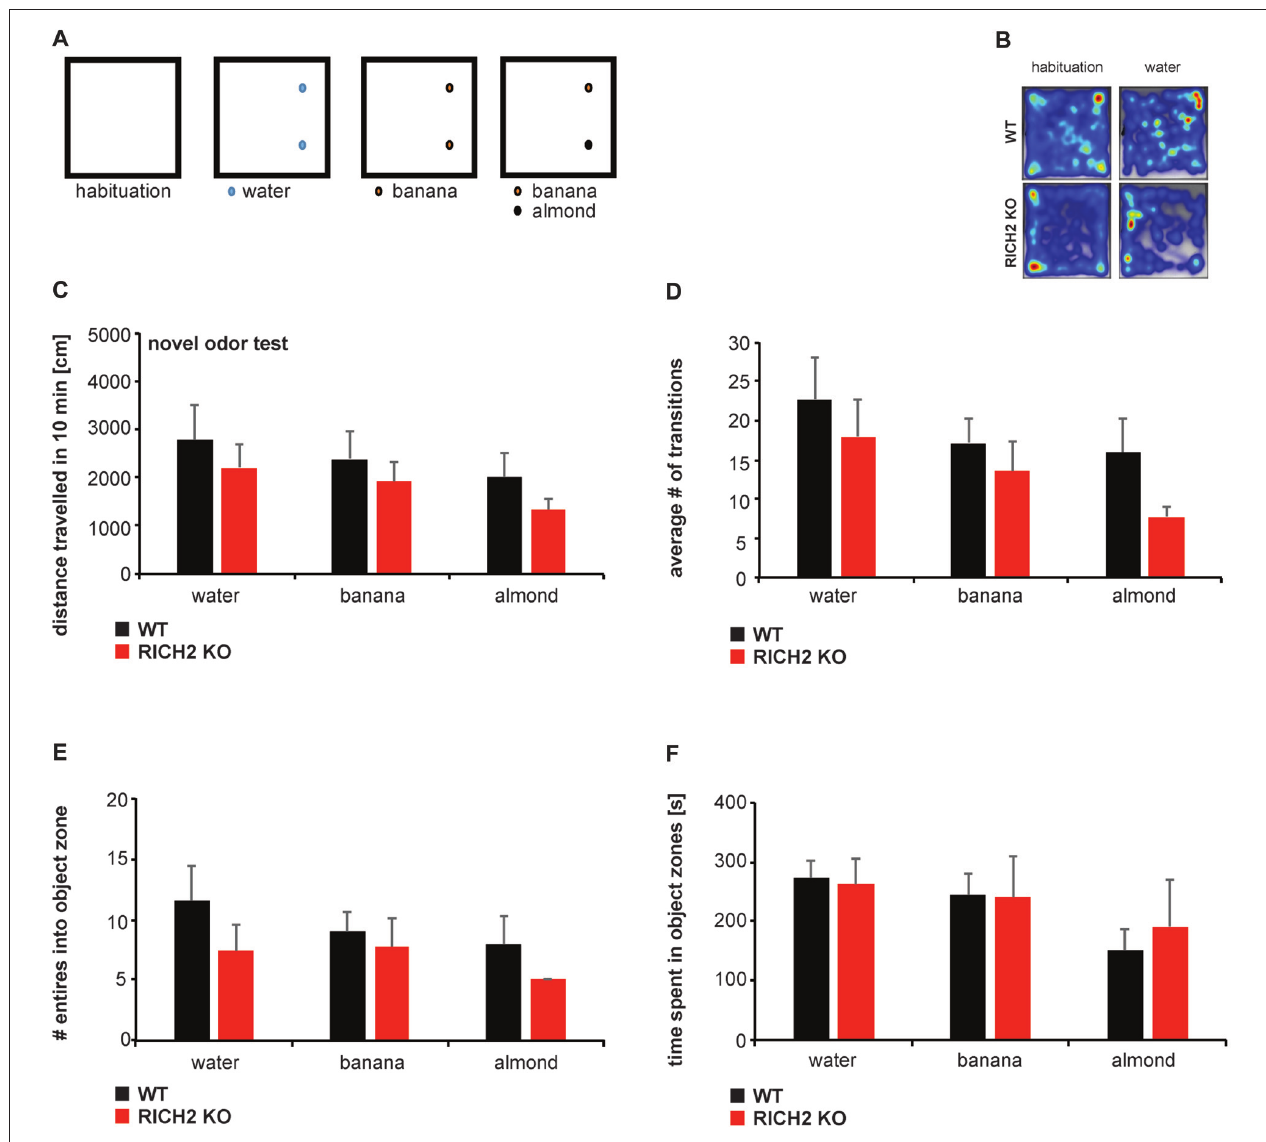
FIGURE 3 | RICH2 KO mice display no neophobia in response to odors. (A) Mice were exposed to water (control), banana, and almond (test) odors for 10 min. Odors were introduced in similar spots as objects in the open field and the response of mice assessed (B) . (C) No significant difference in the distance traveled ( p = 0.5308 for water, p = 0.5045 for banana, p = 0.2682 for almond, unpaired t -test), the number of transitions (D) ( p = 0.5078 for water, p = 0.4687 for banana, p = 0.1036 for almond, unpaired t -test), the entries into object zones (E) ( p = 0.2797 for water, p = 0.6869 for banana, p = 0.2288 for almond, unpaired t -test) and time spent in object zones (F) ( p = 0.8350 for water, p = 0.9398 for banana, p = 0.6450 for almond, unpaired t test) was detected between RICH2 KO mice and WT in response to novel odors ( n = 5 for each